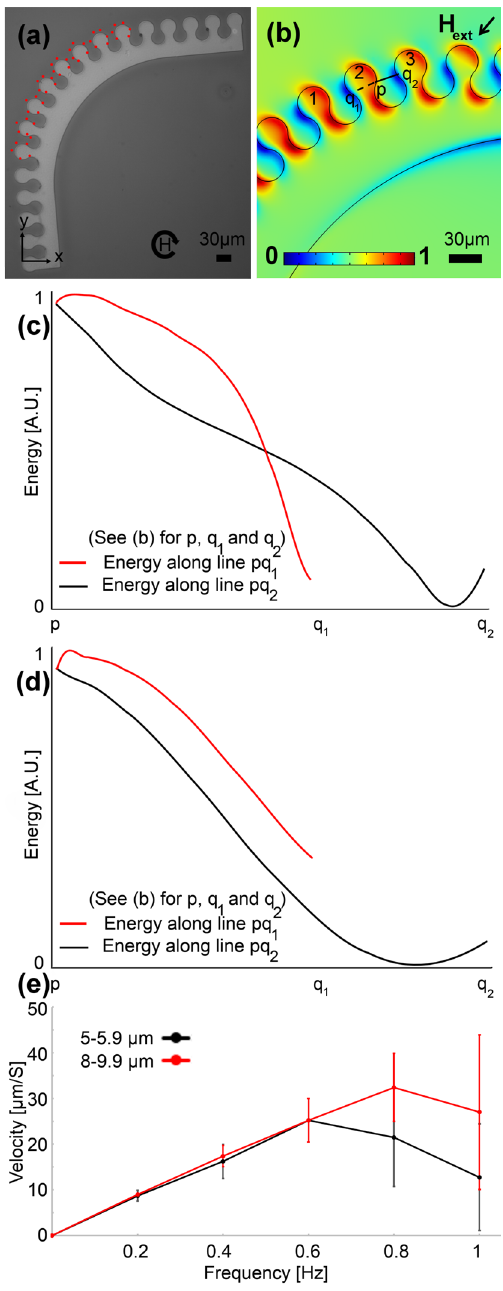
Figure 4. A sample appropriate magnetophoretic bend design. ( a ) The experimental image is shown, where the red dotted line stands for the particle trajectory at a frequency of 0.2 Hz. The circular arrow depicts the magnetic field rotation. ( b ) The magnetic energy landscape simulation result above the substrate is illustrated. The blue and red areas stand for the regions with low and high magnetic energies, respectively. Here, we did a min–max normalization to scale the magnetic energy between 0 and 1 (see the legend). The black arrow depicts the in-plane magnetic field direction, in addition to which a vertical bias field is applied. The magnetic energies along the pq 1 and pq 2 lines in ( b ) (i.e., the dashed and solid lines) are plotted with the red and black curves for particles with a diameter of ( c ) 5 µm and ( d ) 20 µm. The goal is to transport the particles from magnet 1 to magnet 3 via magnet 2. We used a linear scale for the magnetic energy plots and we did a min–max normalization, using the minimum and maximum of the magnetic energy along the pq 1 and pq 2 paths, to scale the energy between 0 and 1. ( e ) The particle velocity versus frequency of the externally applied magnetic field is plotted with the black and red curves for two particle sets with sizes in the ranges of 5–5.9 µm and 8–9.9 µm, respectively. The error bars show standard